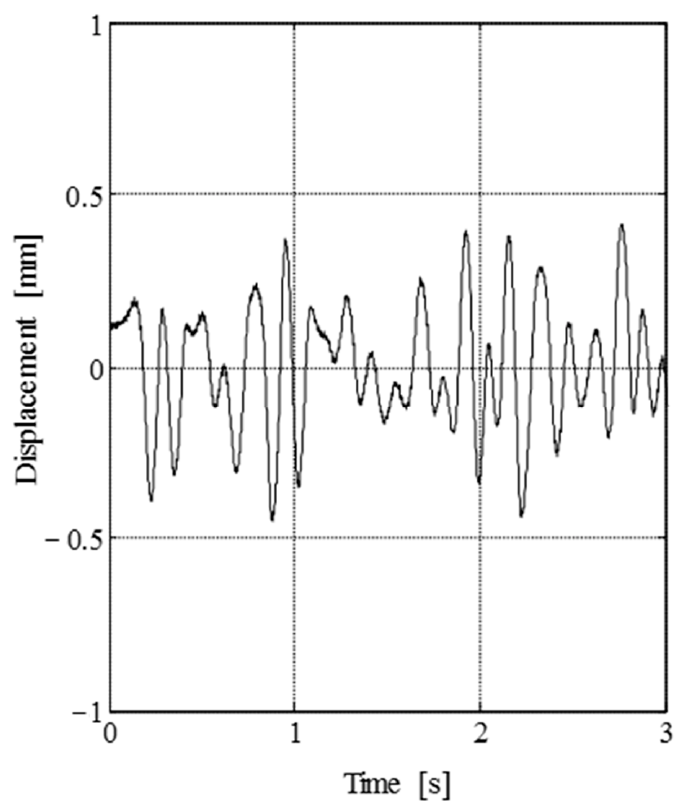
Figure 14. Time series data of vibrating frame displacement under random disturbances.